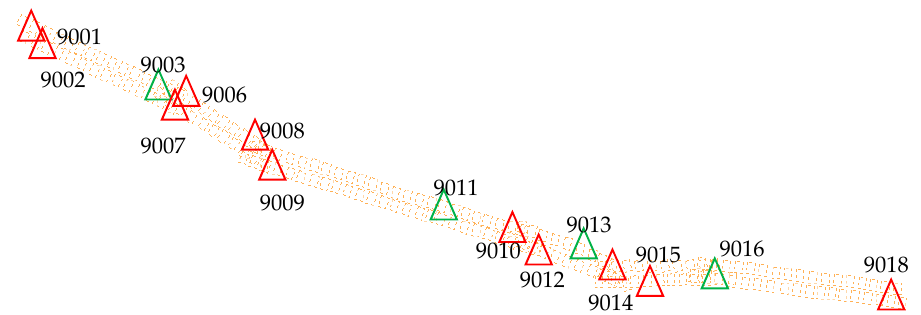
Figure 13. Distribution of the ground control points (GCPs) and check points. The dashed rectangles are images. The red triangles are GCPs and the green triangles are check points.